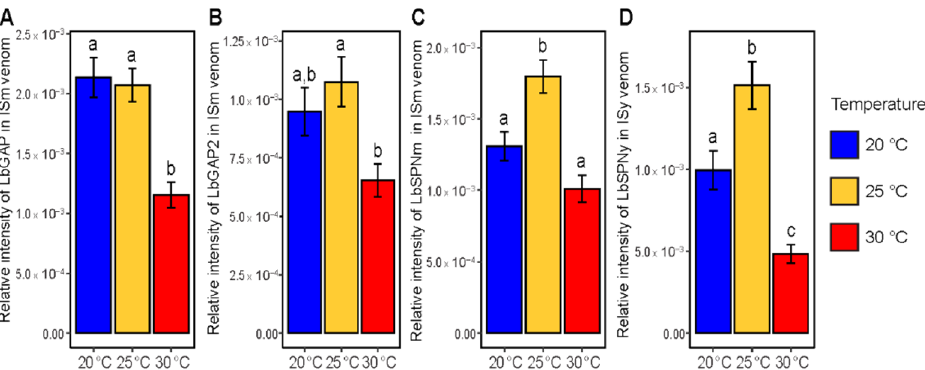
Figure 6. Impact of temperature during parasitoid nymphal development on the amount of specific proteins in the venom. Relative amount of LbGAP ( A ), LbGAP2 ( B ) and LbSPNm ( C ) in L. boulardi ISm venom and of LbSPNy in L. boulardi ISy venom ( D ). Different letters indicate a significant difference between temperatures. Bars indicate standard errors. Table 1. Match between temperature-affected ISm protein bands and their putative protein content determined from comparison with data from [29]. Only proteins for which at least 10 peptide matches were found in Mascot searches with unisequences identified in the venom apparatus tran- scriptomics [29] were considered abundant and were therefore listed. The number of proteins found in the band, their predicted function and the number of peptide matches for each unisequence are provided. Up (“ ↗ ”) and down (“ ↘ ”) arrows indicate an increase or decrease in band intensity in response to increasing temperature. NA: data not available.